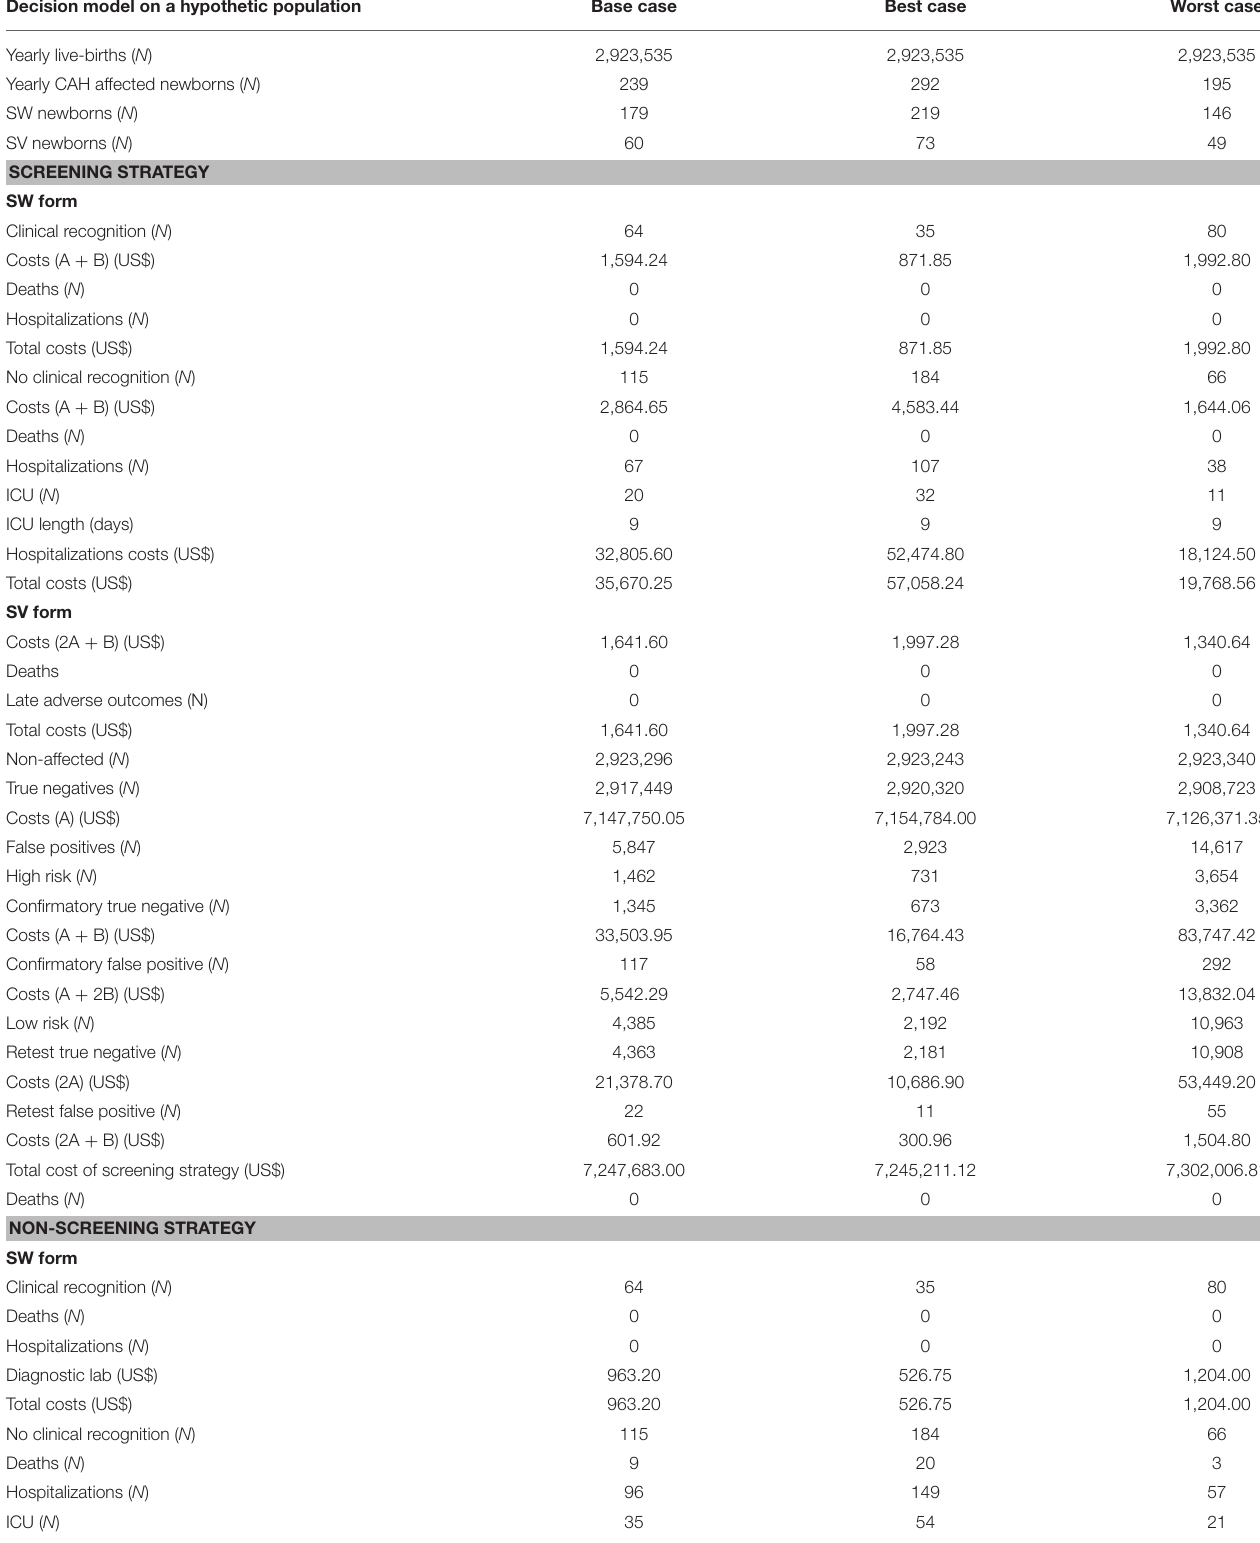
TABLE 3 | CEA for CAH-NBS in Brazil during the year of 2017. Decision model on a hypothetic